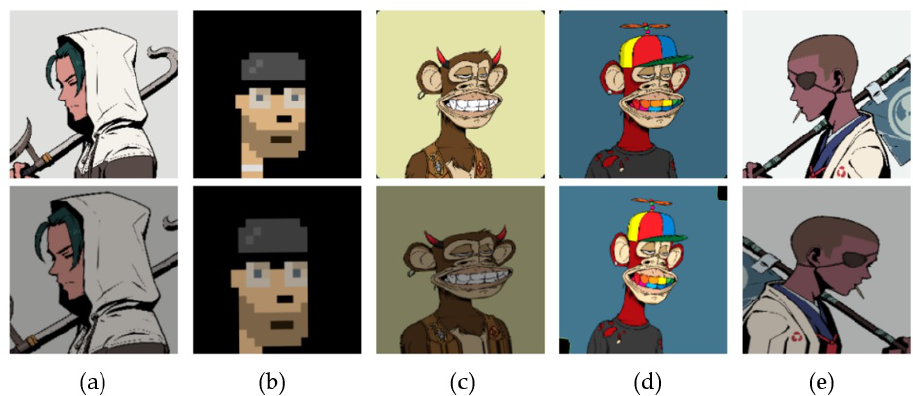
Figure 3. Sample of augmented images of NFT dataset. ( a ) Augmentation in brightness, ( b ) augmen- tation in shear, ( c ) augmentation in scale, ( d ) augmentation in rotation, ( e ) augmentation in horizontal flip. Table 1. List of hyperparameters of ResNet50, DenseNet, MobileNetV2,